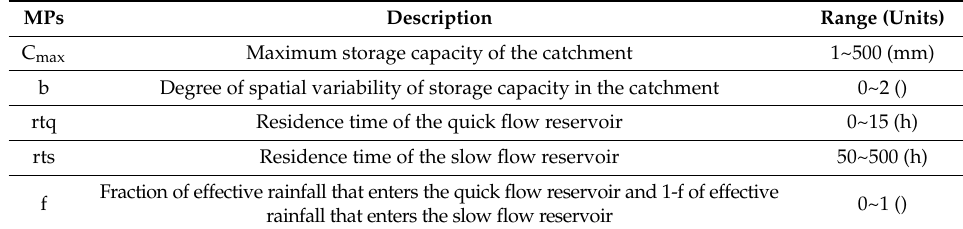
Table 4. Parameters of the PDM